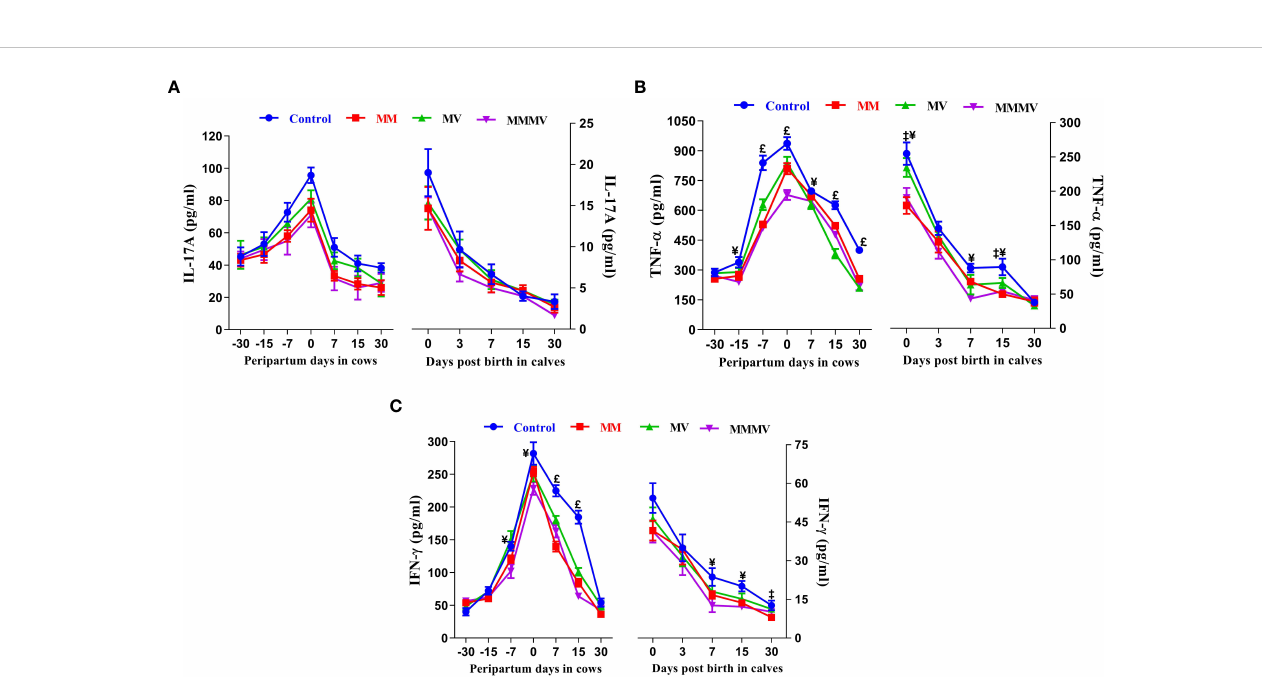
FIGURE 8 The blood plasma concentration of pro-in fl ammatory cytokines (pg/ml) including IL-17A (A) , TNF - a (B) , and IFN- g (C) in control and treatment groups of crossbred cattle and their calves. Control: received basal diet only, MM: basal diet + injectable multimineral, MV: basal diet + injectable multivitamins, MMMV: basal diet + combination of injectable multimineral and multivitamins. The mean values with different superscript symbols represent signi fi cant differences with the control group at different days of peripartum in cows and post birth in calves; ‡ Control Vs MM, † Control Vs MV, ¥ Control Vs MMMV. £ Control Vs MM, MV and